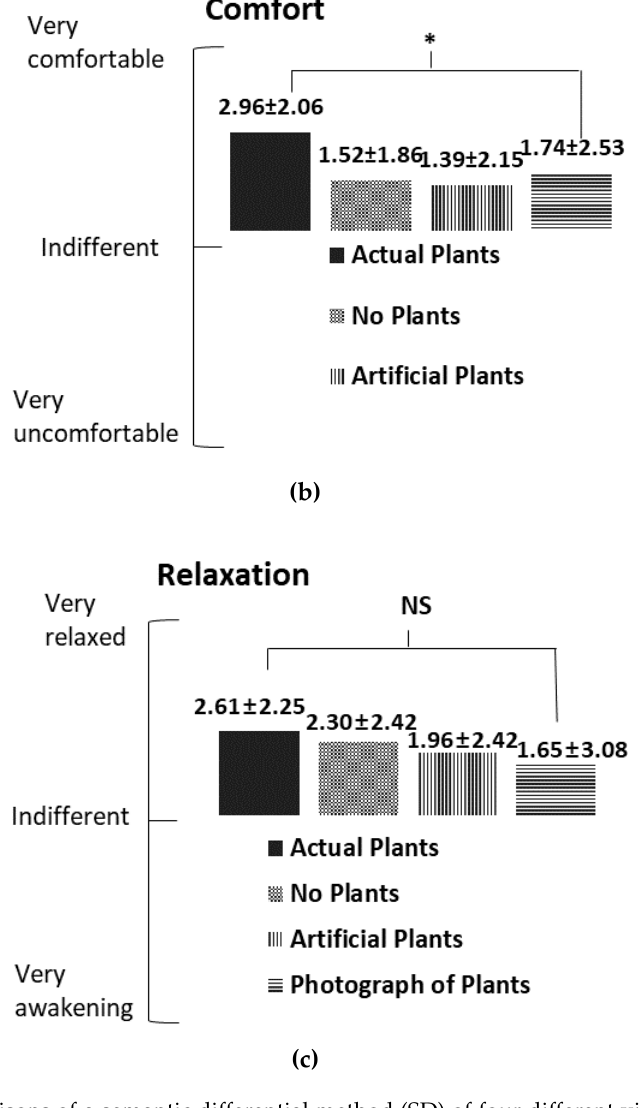
Figure 6. Comparisons of a semantic differential method (SD) of four different visual stimulations. Data are presented as means ± standard deviations. ( a ): natural; ( b ): comfortable; ( c ): relaxation. * p < 0.05; NS, non-significant.